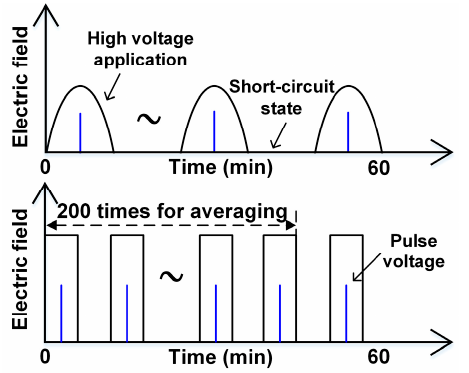
Figure 4. The measurement process for the two kinds of voltages.